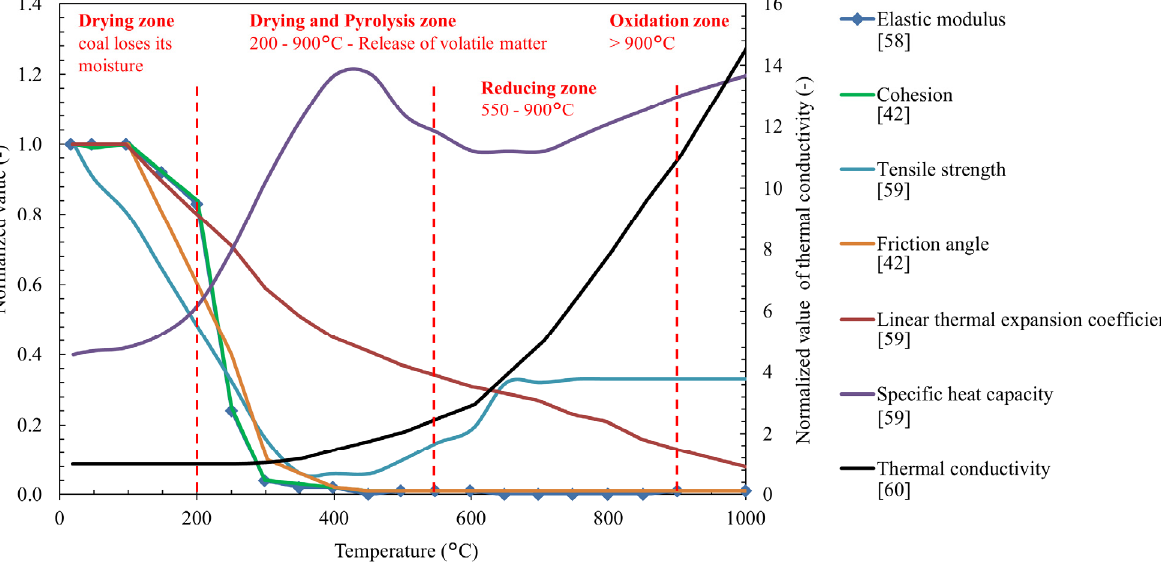
Figure 3. Trend of thermo-mechanical coal properties as a function of temperature. Red dashed lines delimit temperature regions representing the temperature zones exhibiting specific thermo-mechanical coal